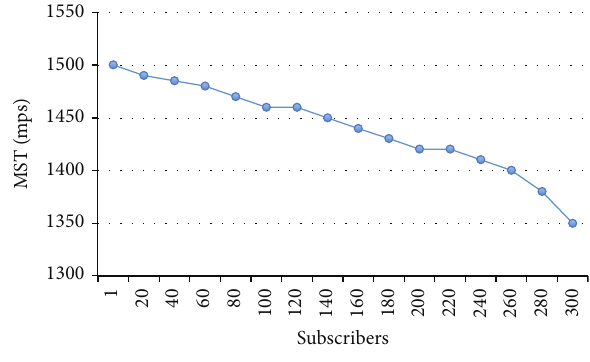
Figure 15: MST versus number of subscribers.